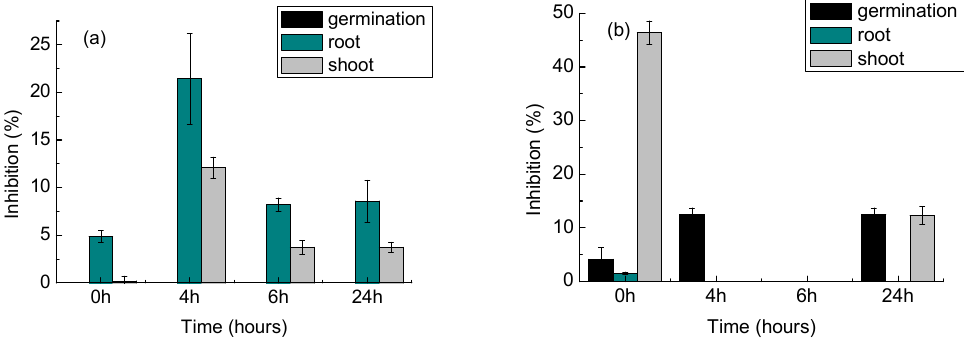
Figure 7. Acute toxicity on ( a ) Lactuca sativa and ( b ) Solanum lycopersicum during photodegradation of DCF using UV light only (i.e., no catalyst). Experiments with the catalyst showed no toxicity at all (data not shown). Error bars refer to standard deviation of quadruplicate measurements of combined duplicate samples.